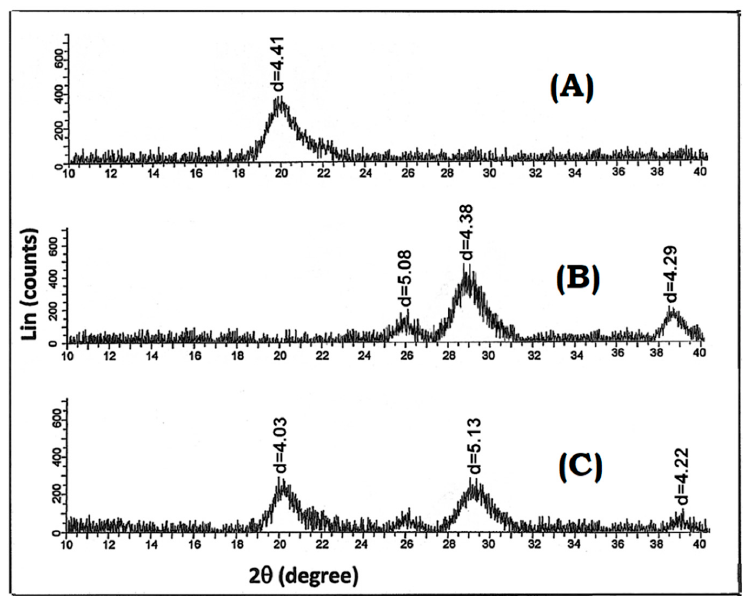
Figure 5. XRD of chitosan ( A ), La 2 O 3 nanoparticles ( B ), and 15 wt% chitosan-La 2 O 3 ( C ).